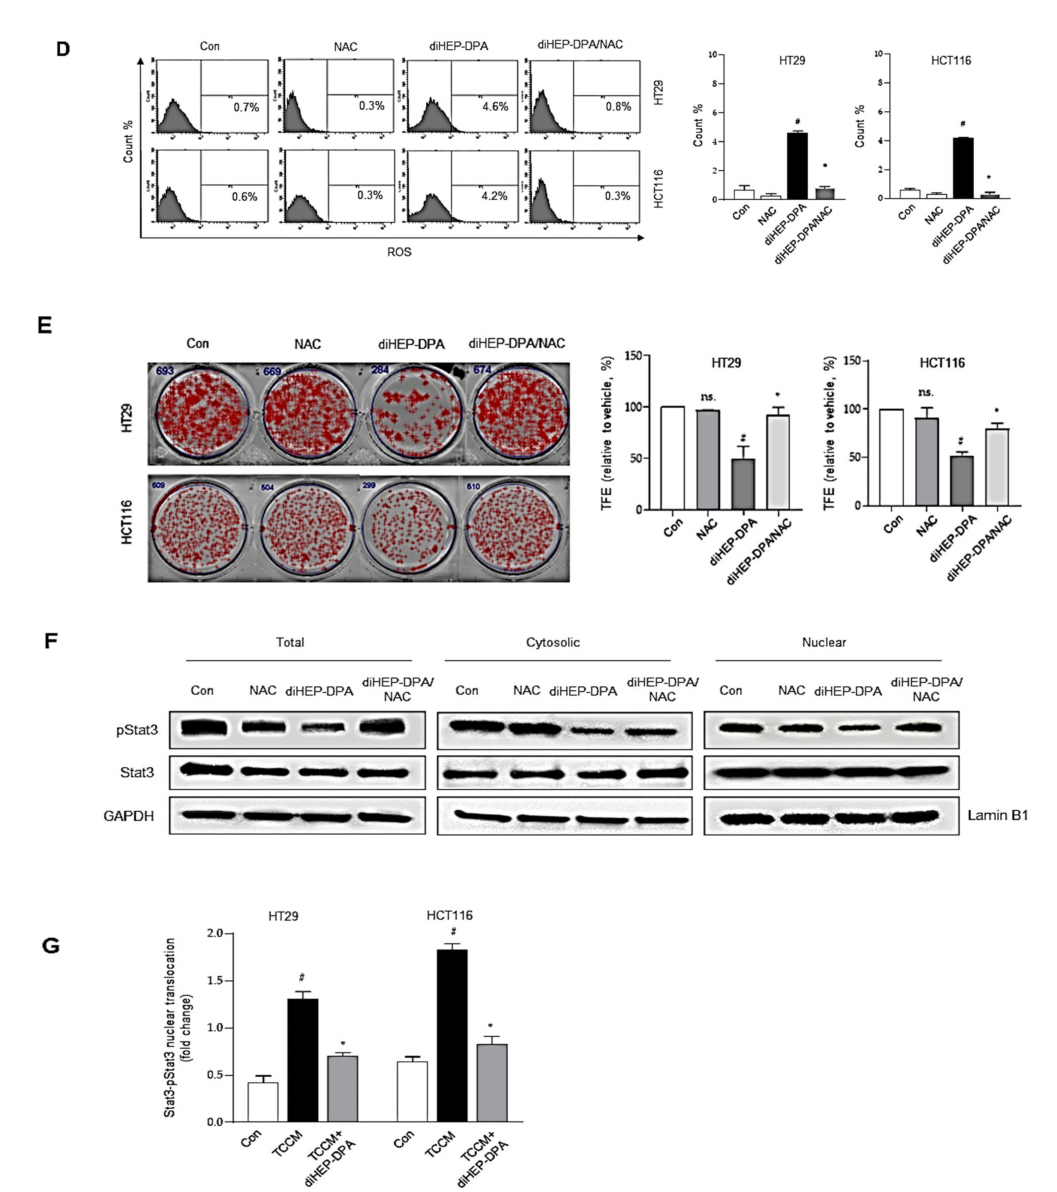
Figure 5. DiHEP-DPA directly affects the stemness of colorectal cancer cells through the ROS/STAT3 signaling pathway. ( A ) Decrease in tumorspheres-formation efficiency (TFE) by treatment with diHEP-DPA (20 µ M). Tumorspheres derived from HT29 and HCT116 cells were cultured for 7 d in the presence of diHEP-DPA or DMSO. Microscopy image shows the sizes of representative tumorspheres. Scale bar: 100 µ m. ( B ) Expression of cancer stemness markers (CD133, CD44, and Sox2), determined by Western blotting using the corresponding antibodies. DiHEP-DPA reduced the expression of cancer stemness markers. ( C , D ) Effect of diHEP-DPA (20 µ M) on ROS generation in HT29 cells, determined using DCF-DA staining. Scale bar: 100 µ m. ( E ) Representative images obtained under 10 × magnification showing reversal of TCCM-DPA–induced reduction in tumorspheres-formation efficiency by the antioxidant, NAC. Tumorspheres formation was determined after 7 d. Scale bar: 100 µ m. ( F ) Effects of diHEP-DPA and NAC on STAT3 phosphorylation. STAT3 activation in tumorspheres, determined by Western blotting using antibodies against pSTAT3, STAT3, GAPDH, and lamin B. DiHEP-DPA decreased the nuclear levels of p-STAT3 in tumorspheres, and the diHEP-DPA-induced dephosphorylation of p-STAT3 was ameliorated by NAC. ( G ) Nuclear protein binding assay showing binding of p-STAT3 with DNA in lysates from tumorspheres treated with diHEP-DPA, determined using a STAT3 Transcription Factor Assay Kit (Cayman). DiHEP-DPA reduced the binding of nuclear p-STAT3 with DNA. Data from triplicate experiments are presented as the means ± SD ( # p < 0.05 versus the DMSO-treated control group; * p < 0.05 versus the TCCM